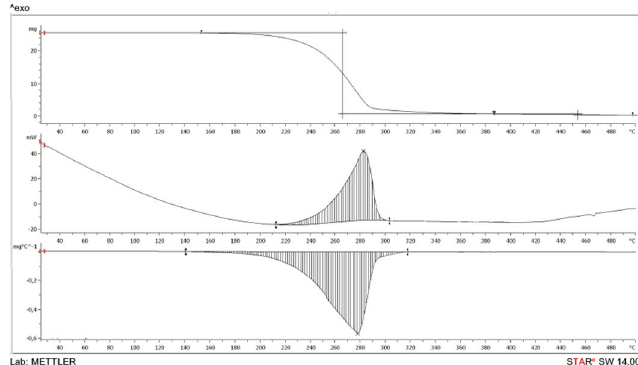
Figure 4. TGA–thermogram of the decyl butoxyethyl adipate.